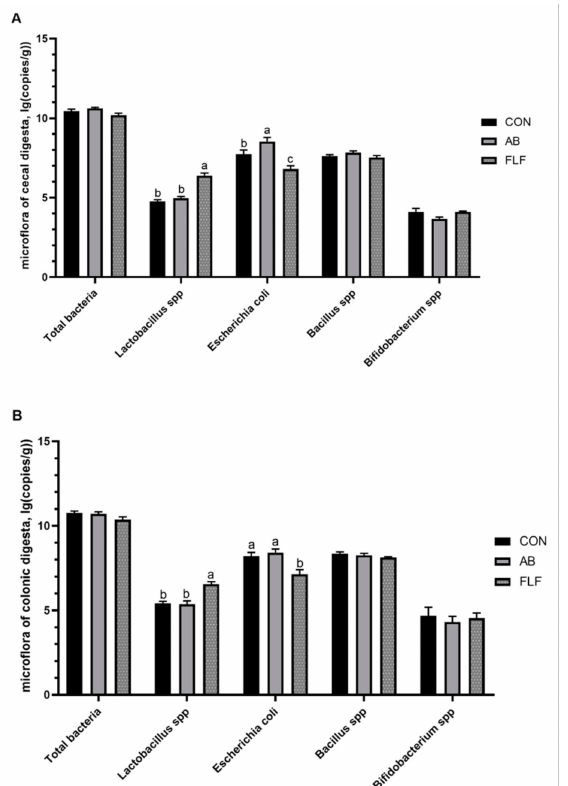
Figure 2. Effects of fermented liquid feeding on the contents of microflora in the cecal ( A ) and colonic ( B ) digesta of pigs (lg (copies/g)). Values are means ± SEM, ( n = 6). CON: control group; AB: antibiotics group; FLF: fermented liquid feeding group. a, b, c mean values with different letters on vertical bars indicate significant differences ( P <